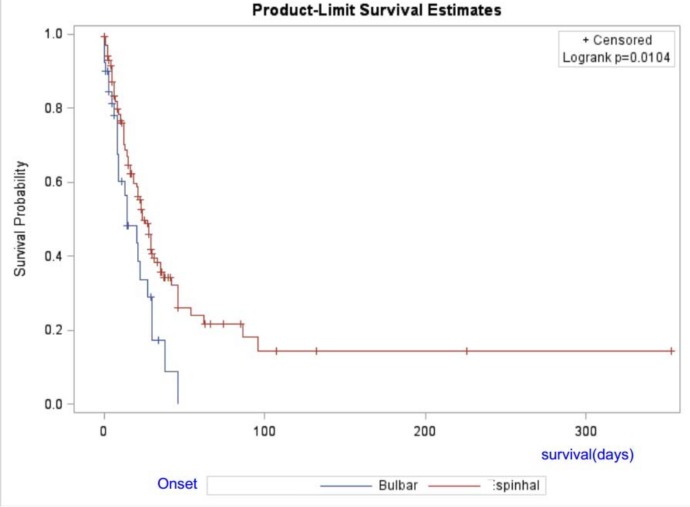
Survival of Amyotrophic Lateral Sclerosis patients taking riluzole in Federal District.